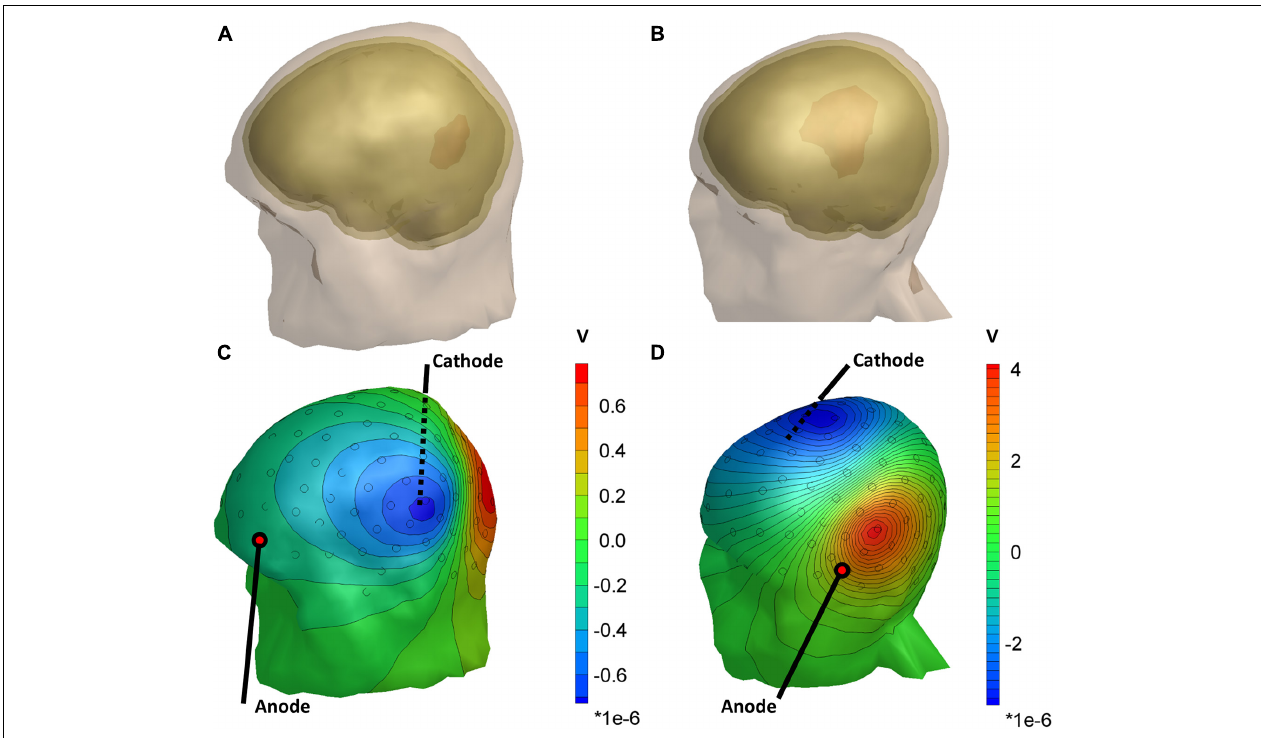
FIGURE 2 | Head models of subject 035 (A) and subject 055 (B) , showing the lesion volume in red. (C,D) The distribution of the difference in scalp potentials between the models with and without the lesion and isopotential lines for the optimal stimulation pair. Black circles represent the 128 measurement electrodes. Note that the magnitude of the color bar varies between the two